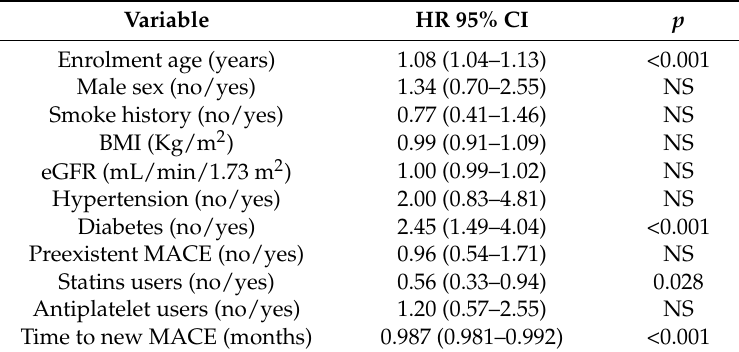
Table 2. Classic Cox proportional hazard regression analysis.